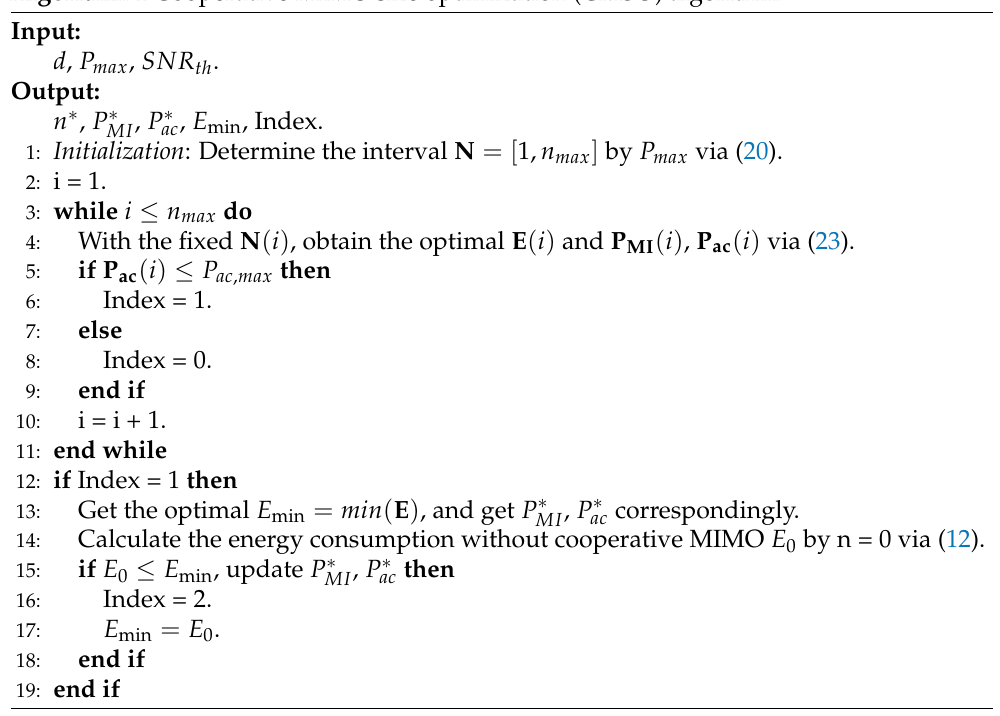
Algorithm 1 Cooperative MIMO size optimization (CMSO)